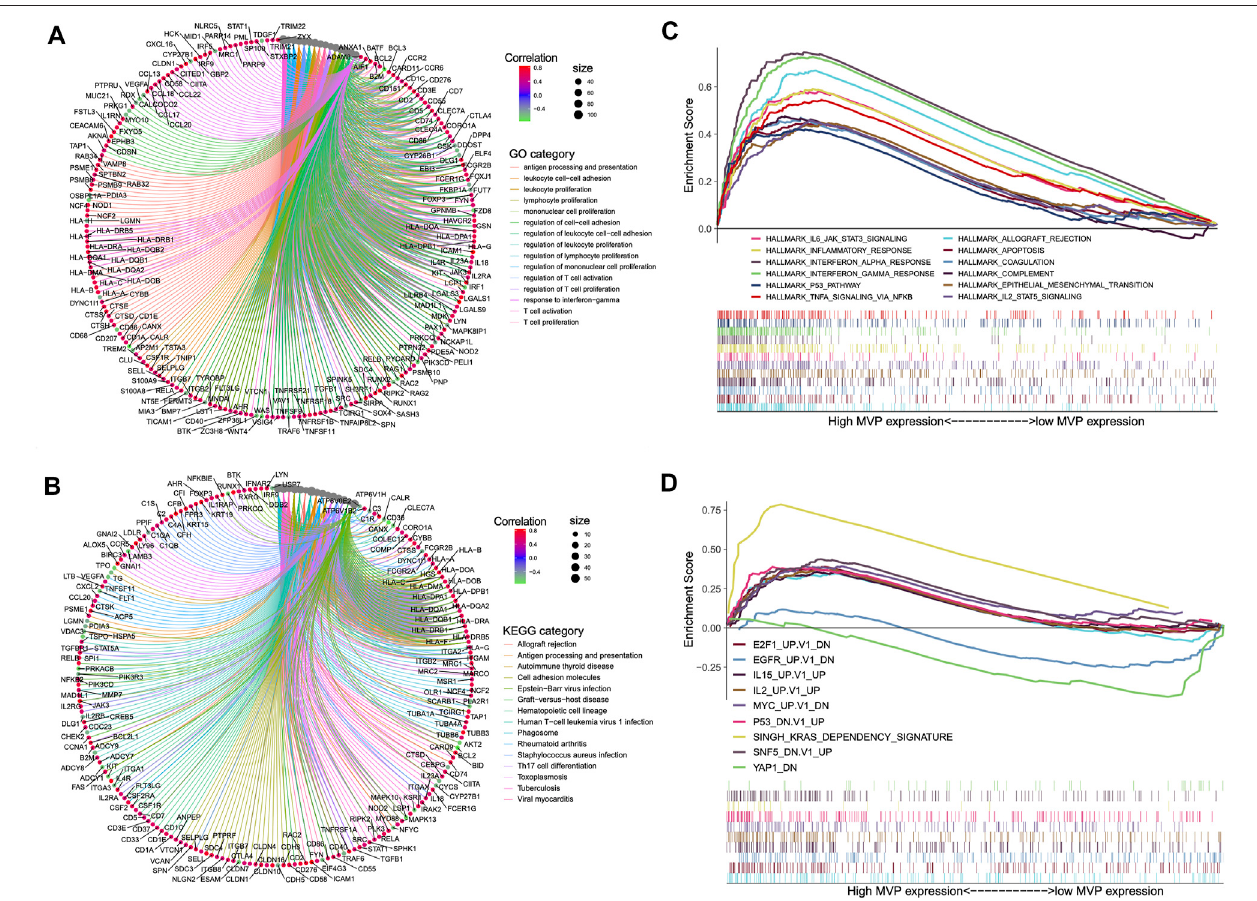
FIGURE 5 | Summary of MVP co-expressed genes and functional enrichment analyses. Gene ontology (A) and KEGG pathways (B) were considerably related to MVP expression. Genes strongly co-expressed with MVP are exhibited in order of Spearman ’ s correlation coef fi cient. (C) GSEA presented crucial hallmarker terms enriched in high (up) MVP expression subgroup. (D) GSEA exhibited key oncogenic terms enriched in high (up) and low (down) MVP expression subgroup. The cutoff value between high (up) and low (down) level MVP is the median value in the cohort. Entire lists are shown in Supplementary Table S5 – S7 .